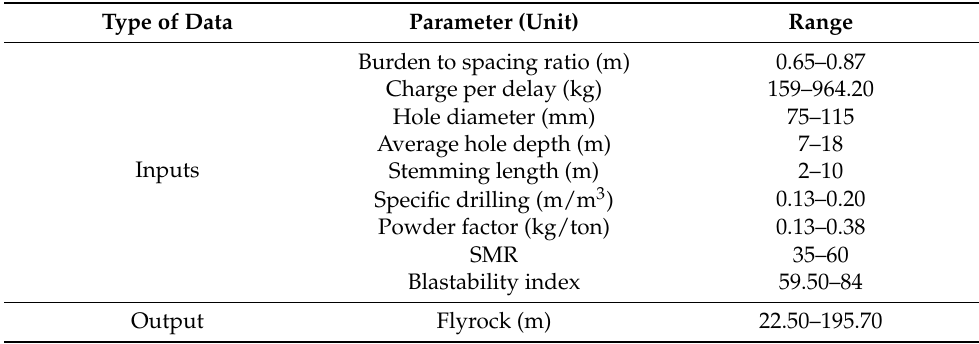
Table 1. The input and output parameters used in ANN